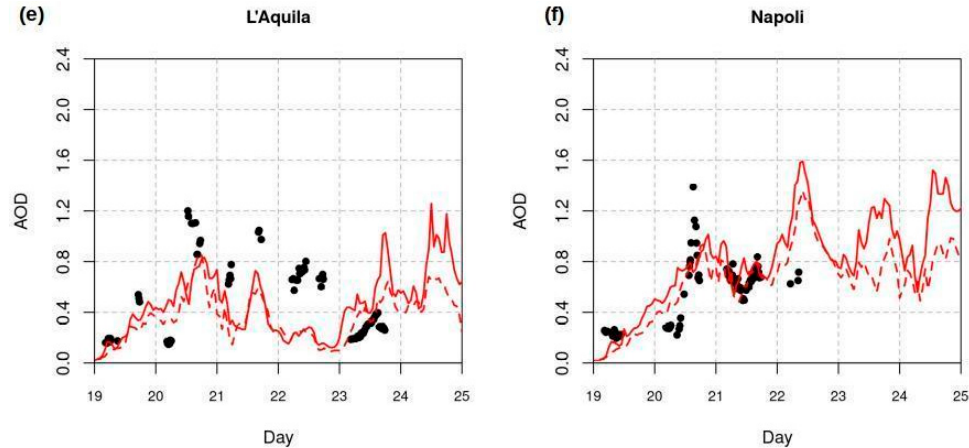
Figure 8. Time series of AOD at 0.55 µ m as derived from simulations (continuous and dotted red lines for the CTL and FULL run, respectively), AERONET measurements (black bullets), and ALICENET retrievals (blue bullets) during the period 19–24 June 2021 ( x -axis) at different Mediterranean sites: ( a ) Roma, ( b ) Messina, ( c ) Capo Granitola, ( d ) Ersa, ( e ) L’Aquila, and ( f ) Napoli.